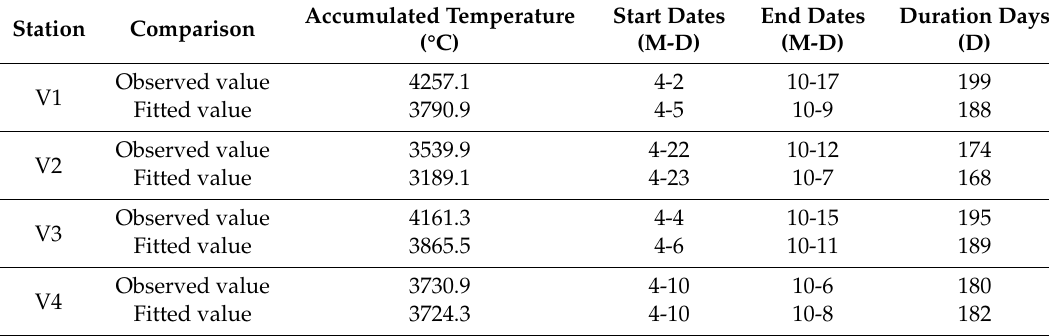
Table 2. Comparison of observed and fitted values of T ≥ 10 ◦ C accumulated